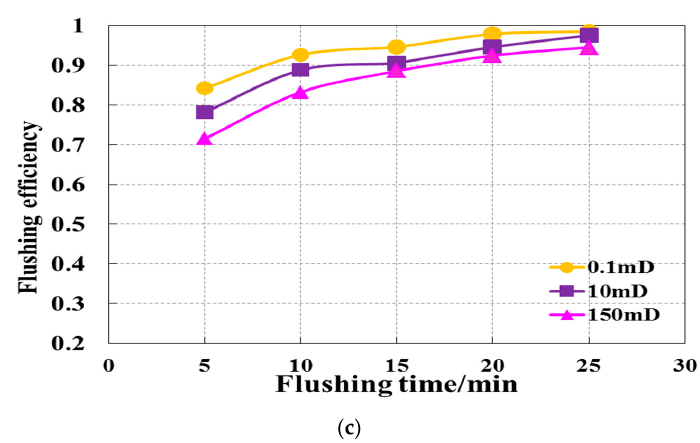
Figure 12. Change chart of flushing time and flushing efficiency of different cores with 30% flushing concentration. ( a ) is flushing displacement 10 L / min, ( b ) is flushing displacement 25 L / min, ( c ) is flushing displacement 35 L / min.